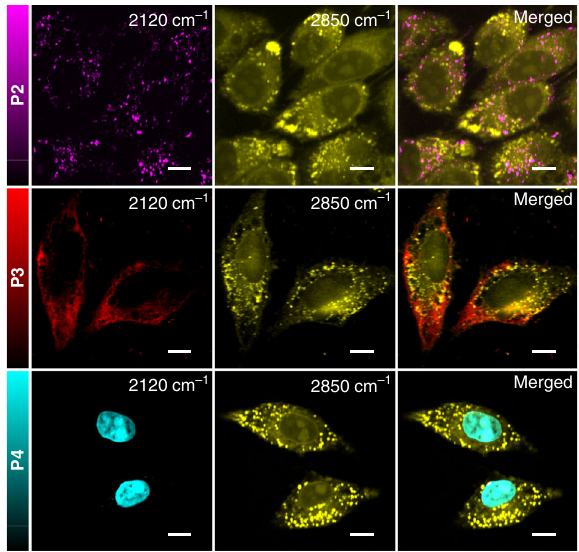
Fig. 7 SRS images of HeLa cells treated with 50 μ M of P2, P3, and P4, respectively. Images shown from left to right are the alkyne (2120 cm − 1 ), lipids (2850 cm − 1 ), and merged images. Scale bar: 10 μ Methods Preparation of PDDA . In a typical run, 27.0 mg of host 1 was dissolved in 30mL methanol with sonication to give a colorless solution. 19.4mg of DDA was then added to the above solution and the mixture was centrifuged at 2400 × g for 10min to remove possible dust impurities. The resulting solution was transferred to a crystallization dish and kept in 4°C. The slow evaporation of the solvent generated white needle-like crystals in the crystallization dish. Heating the crystals in an oven set at 120 °C for 12h turned the color of the crystals from pink to dark red then metallic gold. The fi nal product was characterized with X-ray single crystal dif- fraction and Raman spectroscopy, which con fi rmed that the gold-colored crystals were PDDA-host 1 co-crystals. The crystallographic data have been deposited in the Cambridge Crystallographic Data Center (CCDC) with an accession number of CCDC: 1900689.